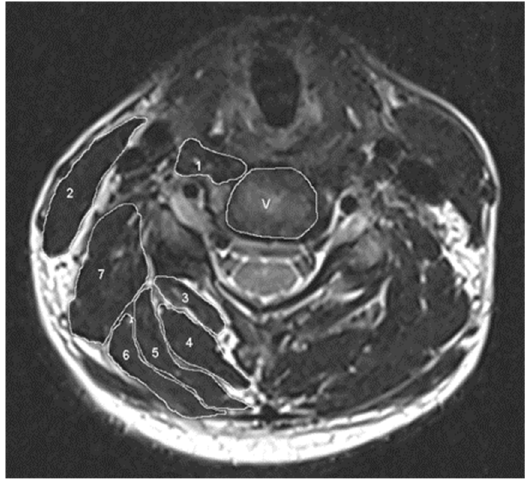
Figure 3. Measurement of the cross-sectional area (CSA) of the paraspinal muscles and vertebral body in C5/6 level by ImageJ software. The following paraspinal muscles were included: 1. longus colli and longus capitis; 2. sternocleidomastoid; 3. multifidus; 4. semispinalis cervicis; 5. semispinalis capitis; 6. splenius cervicis and splenius capitis; 7. levator scapulae and V. vertebral body.